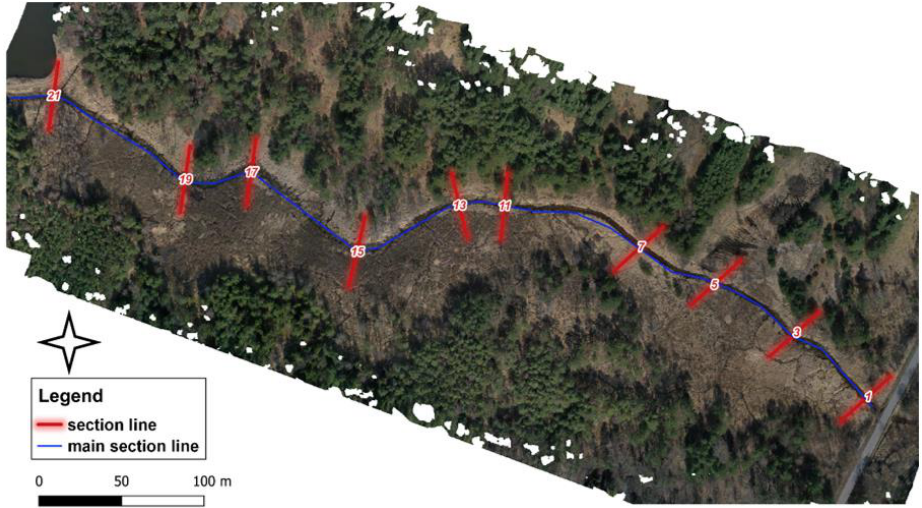
Figure 6. Location of selected cross-sections; orthophotomosaic created by Szymon Sobura; illustration — own elaboration.